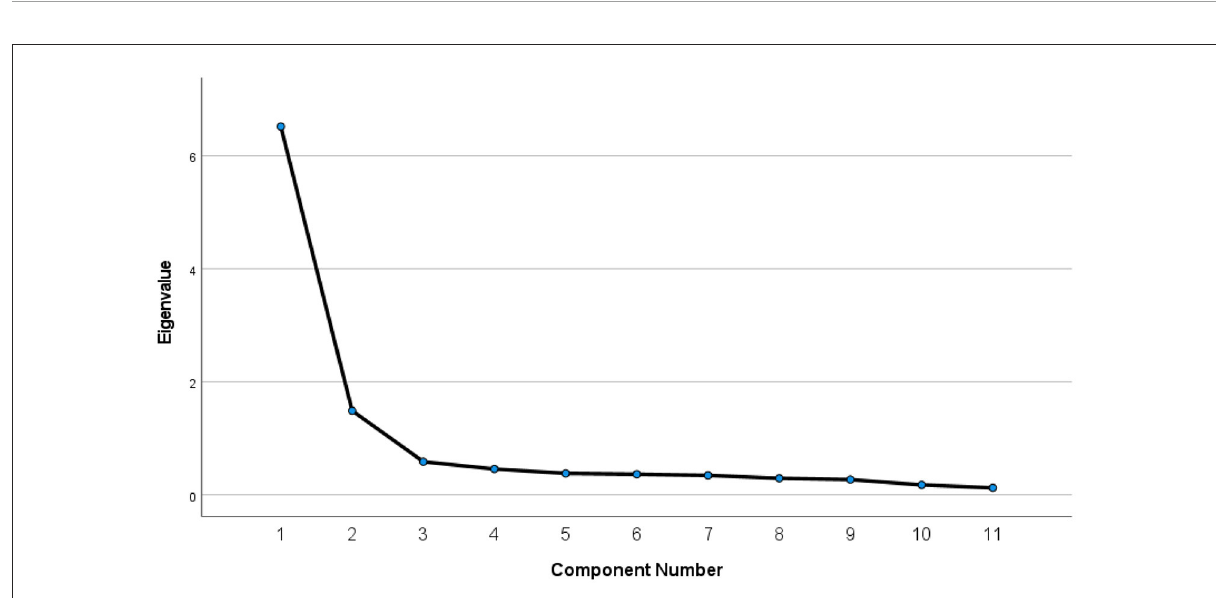
FIGURE1 Scree plot for entire